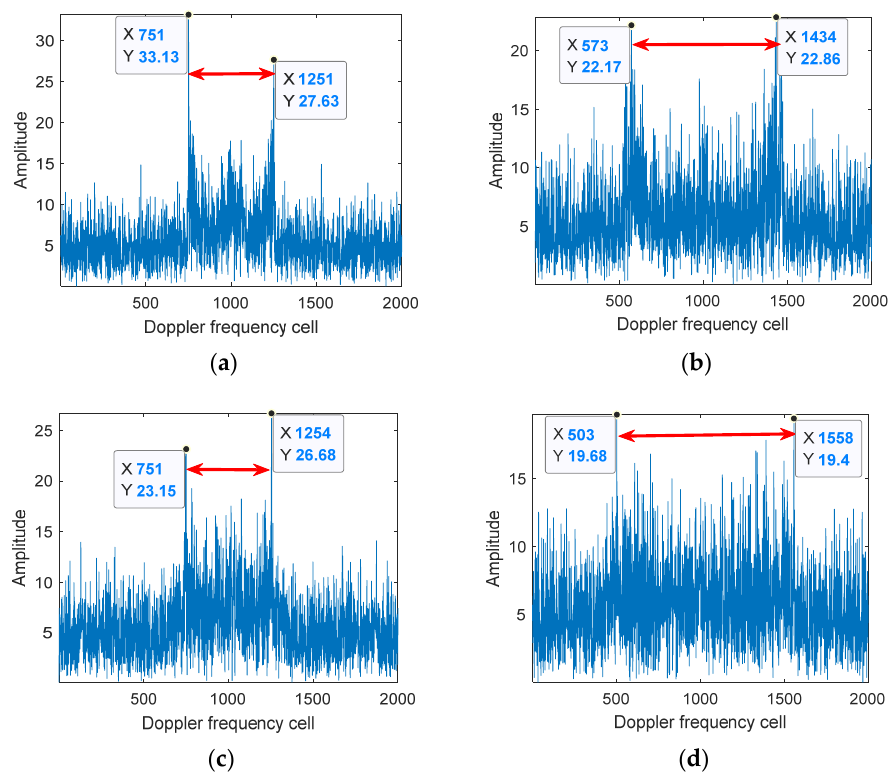
Figure 6. Micro-Doppler spectrum broadening variation when the rotation frequency changes. ( a )